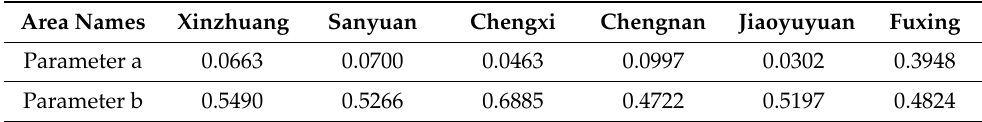
Figure 8. SWMM model used for evaluation of storage capacity. According to the water quantity and quality monitoring data, the parameters of wastewater generation and infiltration of the dry weather day were calibrated. The result of calibration is shown in Figure 9a, using the water level at the outlet of the area as the calibration data, which exhibits good results with the Nash efficiency coefficient reaching above 0.9.